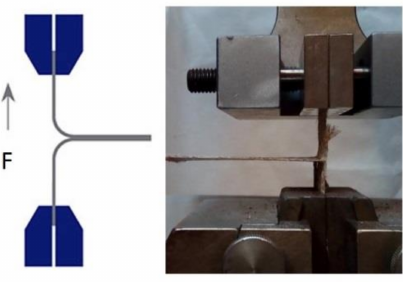
Figure 3. T peeling test